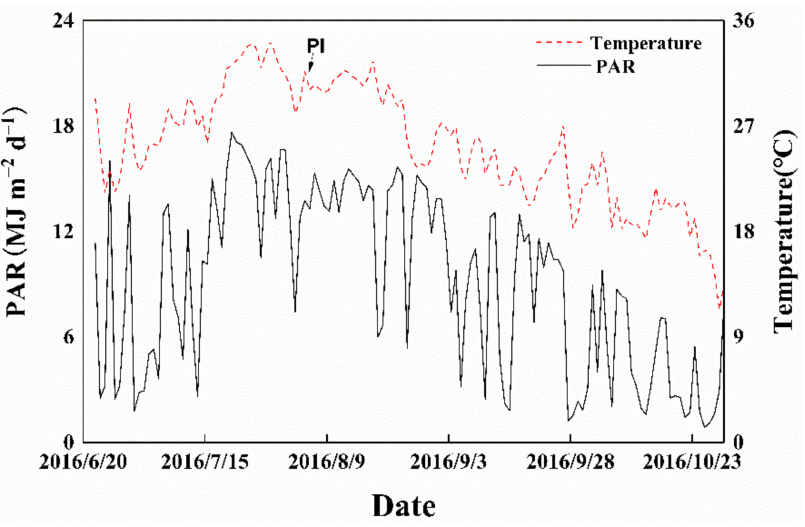
Figure 1. Meteorological parameters during the rice